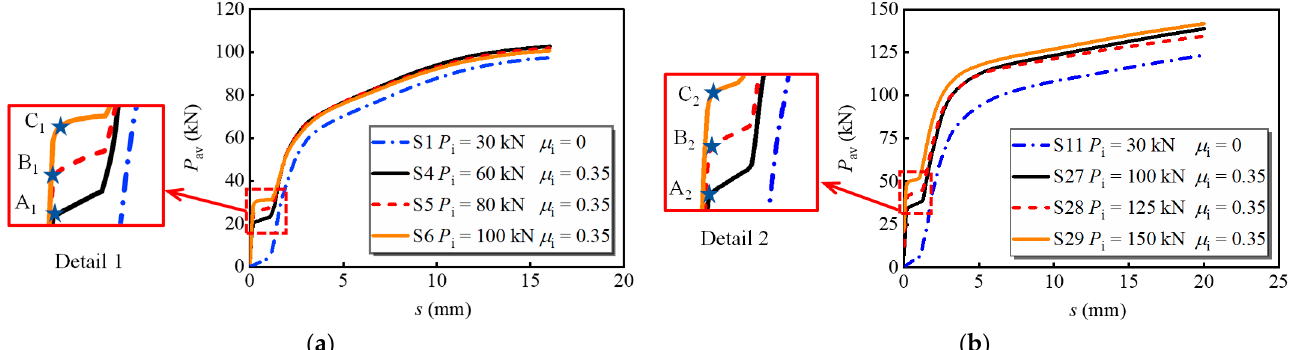
Figure 11. Average load versus slip curves for models with different bolt preloads: ( a ) d bolt = 16 mm; ( b ) d bolt = 20 mm.